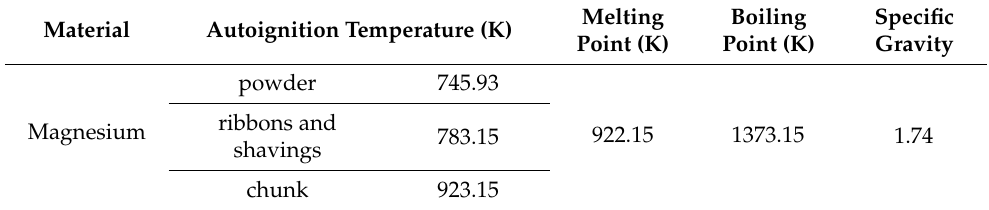
Table 1. The physical properties of magnesium.